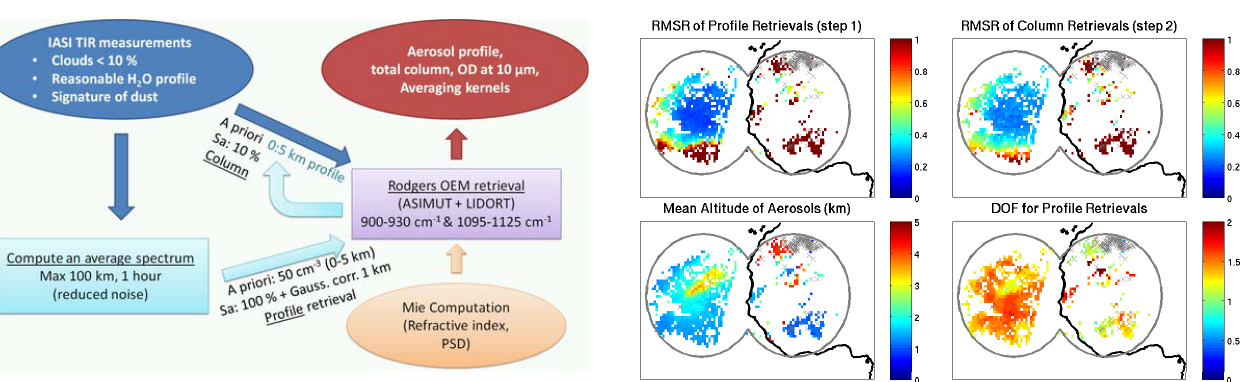
Fig. 7. Information on IASI day-time retrievals above land and off- shore on 22 June 2009: root mean square of the residuals (RMSR) in BT for both steps of the retrieval, mean altitude of the aerosols and number of degrees of freedom (DOF) for the vertical profile retrieval step. Data was binned to a 0.5 ◦ × 0.5 ◦ latitude/longitude grid. The thick grey line represents the limits of the IASI data set treated in this work. The grey crosses show unsuccessful retrievals. White space represents places where no retrieval was attempted be- cause of the pre-filters.